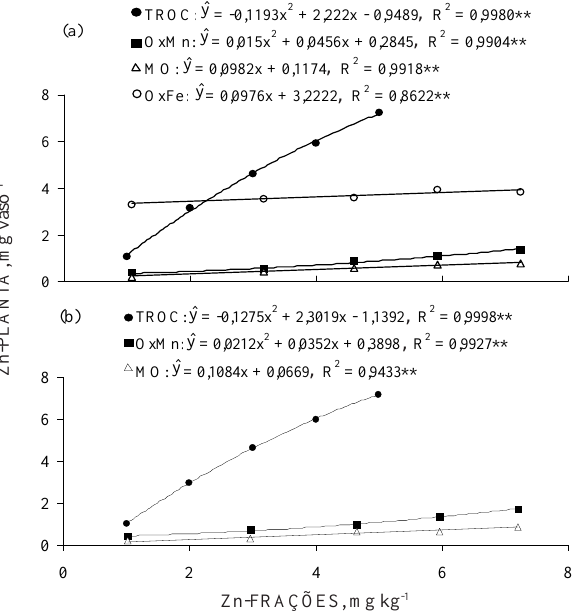
Figura 5. Relação entre o zinco na parte aérea da planta e as frações de zinco em amostras de solo sem calagem (a) e com calagem (b), coletadas depois do 3 o corte.